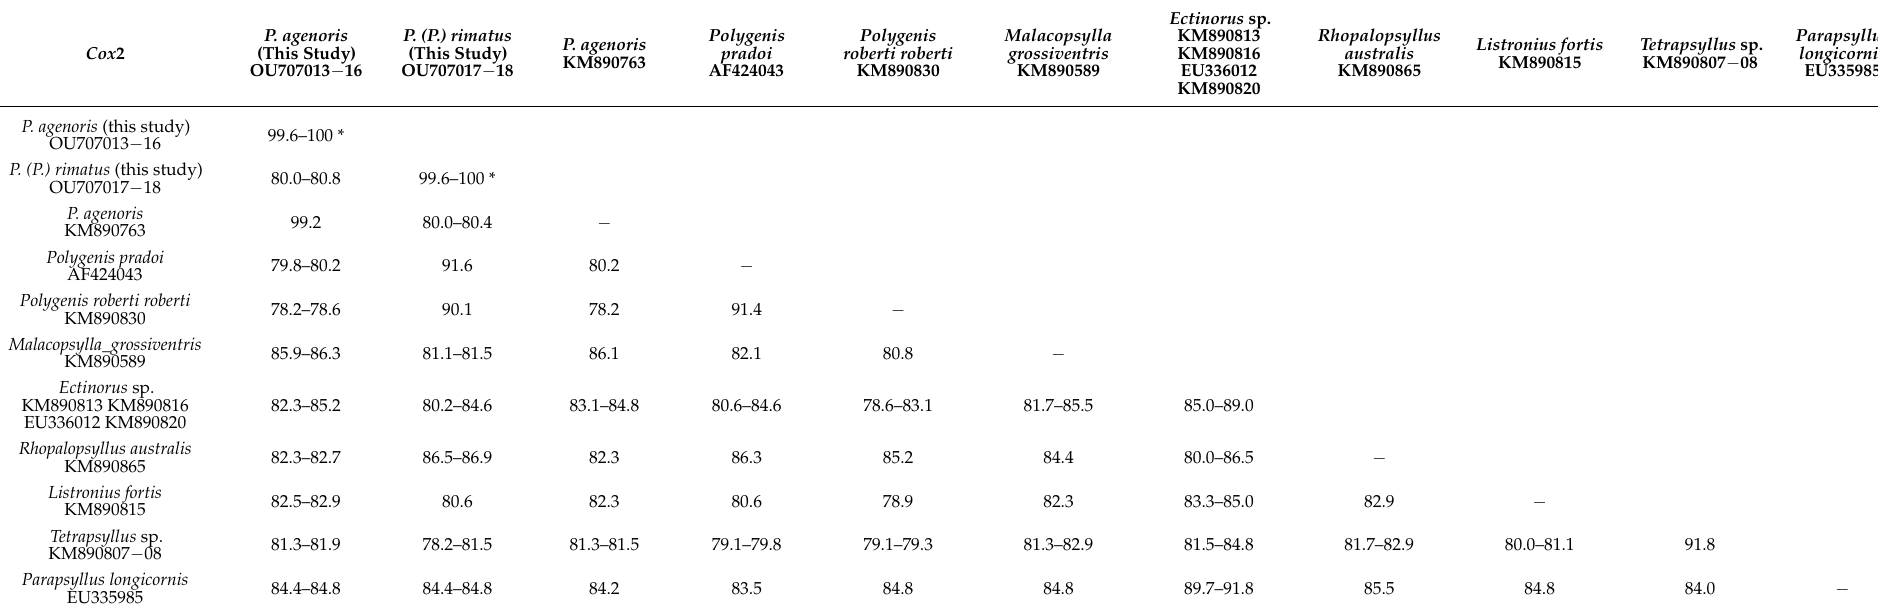
Table 5. Intraspecific (*) and interspecific similarities observed among all partial cox 2 mtDNA gene sequences of P. agenoris and P. (P.) rimatus (obtained in this study) and different species and genera belonging to Rhopalopsyllidae and Malacopsyllidae families retrieved from GenBank database. Values are given in